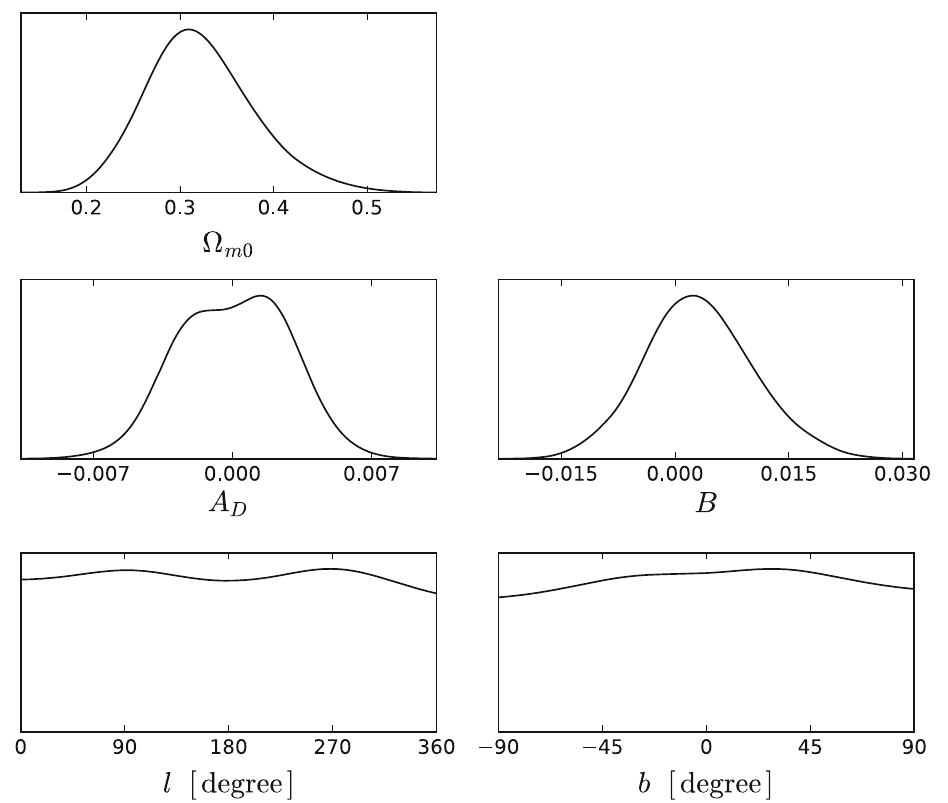
Fig. 4 The marginalized probability distributions of (cid:8) m 0 , the dipole magnitude A D , the monopole term B , and the dipole direction ( l , b ) , obtained by using the DF method to the Pantheon data. See the text for details